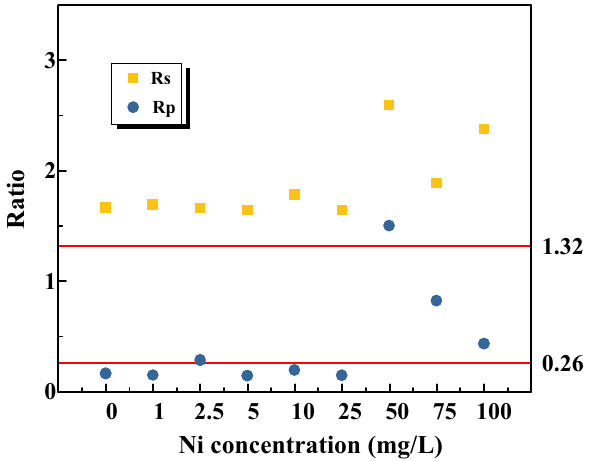
Figure 1. The Rs and Rp values with different Ni(II) addition.